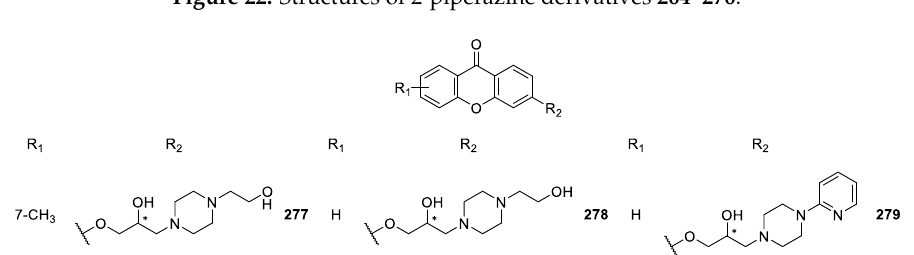
Figure 22. Structures of 2-piperazine derivatives 264 – 276 .